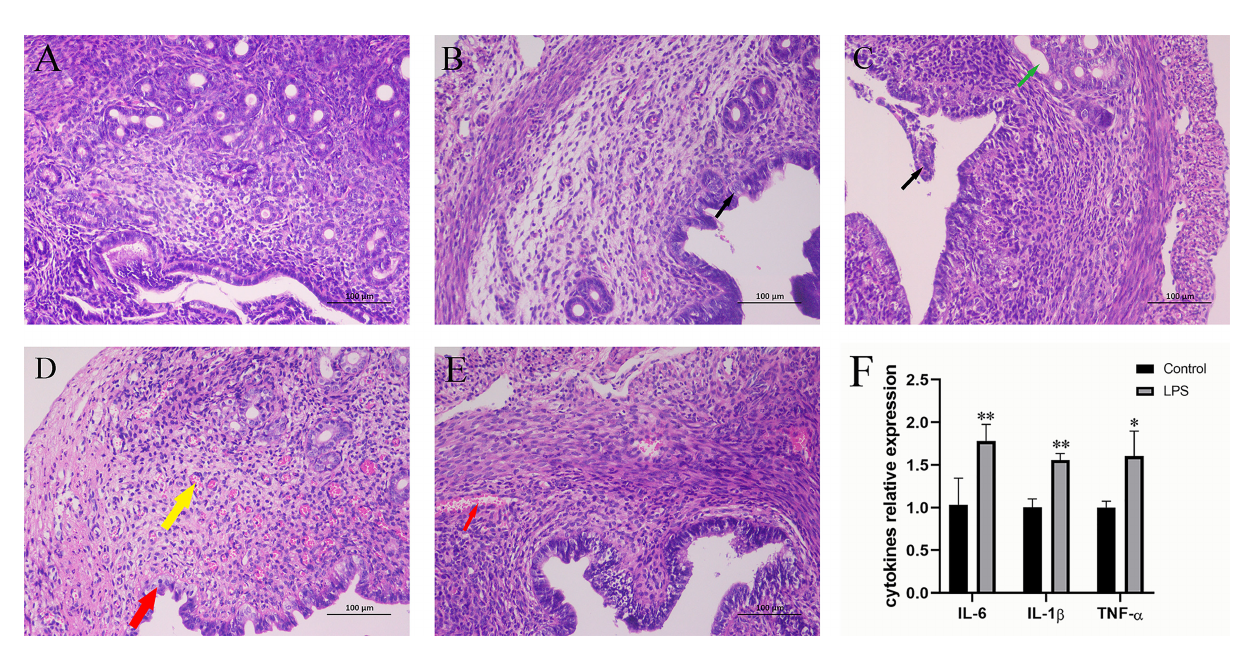
FIGURE 1 | Effect of LPS on in fl ammation of the mouse uterus. (A) Control group. (B) LPS group (3 h). A small amount of endometrial epithelial cells seems swollen, and the cytoplasm is loose and light-stained (black arrow). (C) LPS group (6 h). Bits of endometrial epithelial cells are shed (black arrow), and a small number of uterine glands are slightly dilated (green arrow). (D) LPS group (12 h). The endometrial epithelium and glandular epithelium are swollen, the cytoplasm has loosened and lightly stained (red arrow), and a large number of capillaries in the lamina propriety are congested and dilated (yellow arrow). (E) LPS group (24 h). A spot of blood stasis in the lamina propria (red arrow). (Hematoxylin and eosin staining; magni fi cation, 200×). (F) The expression of in fl ammatory cytokines IL-6, IL-1 b , and TNF- a . Mean ± SD was employed for data processing. Three replicates were processed in each group. *p < 0.05, **p < 0.01 vs. control